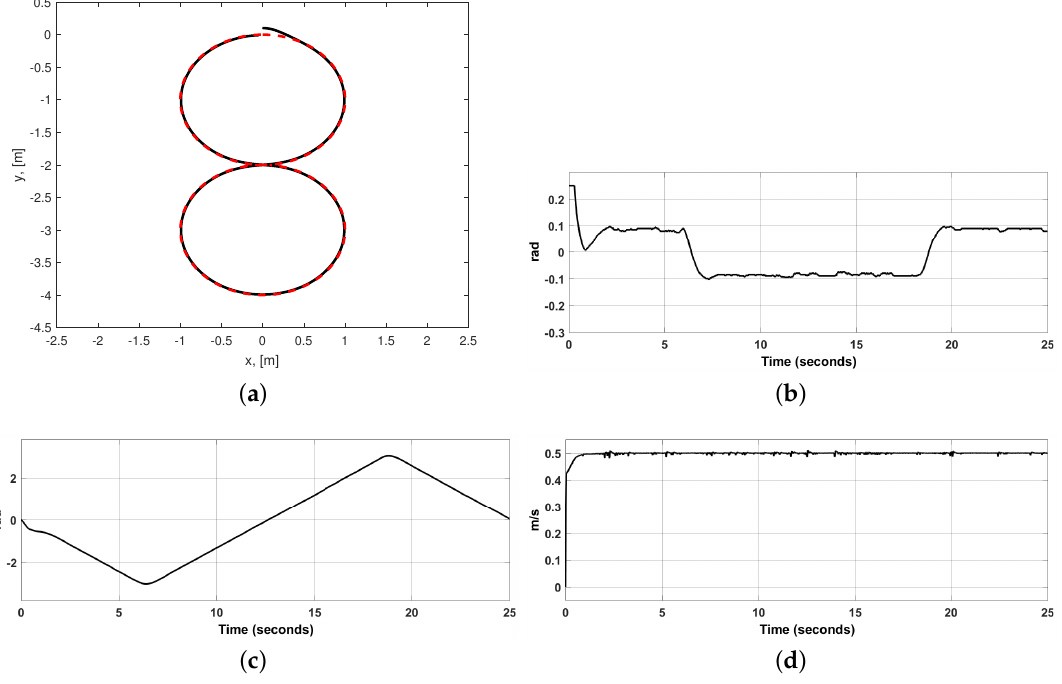
Figure 5. Path-tracking variables. ( a ) Dashed: desired path. Continuous: actual WMR position. ( b ) Tracking error φ e . ( c ) Actual WMR orientation φ . ( d ) Translational velocity v